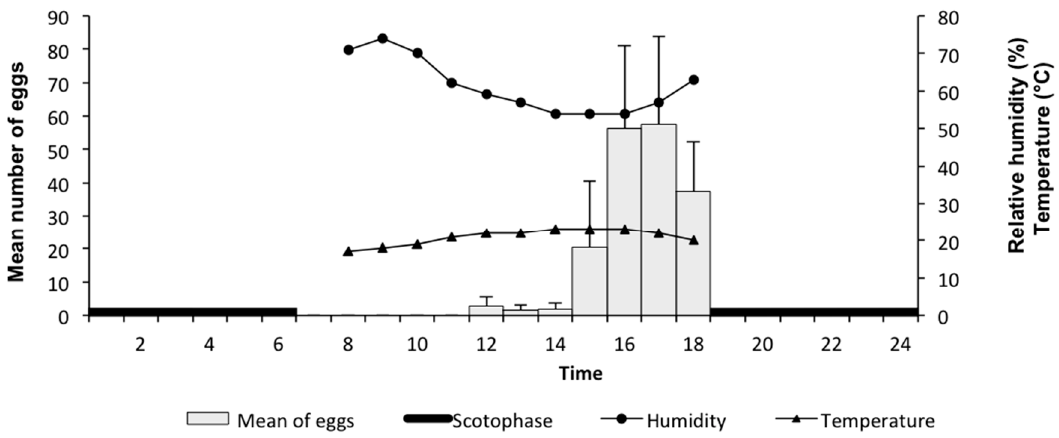
Figure 1. Mean (X ± SEM) number of eggs laid by Lucilia cuprina as a function of time during the photophase.